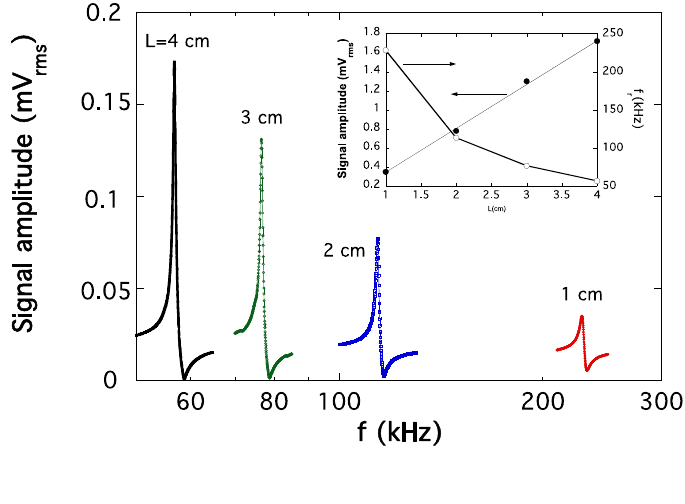
Figure 16. Magnetoelastic resonance curves measured for different ribbon pieces with length ranging from 4 cm to 1 cm. The inset shows also the measured resonance frequency and the induced signal at the resonance, as a function of the length of the resonant magnetostrictive